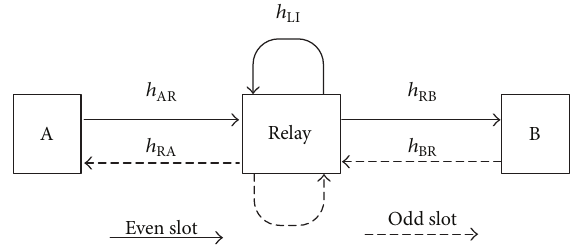
Figure 1: Two-way AF relay channels with full-duplex